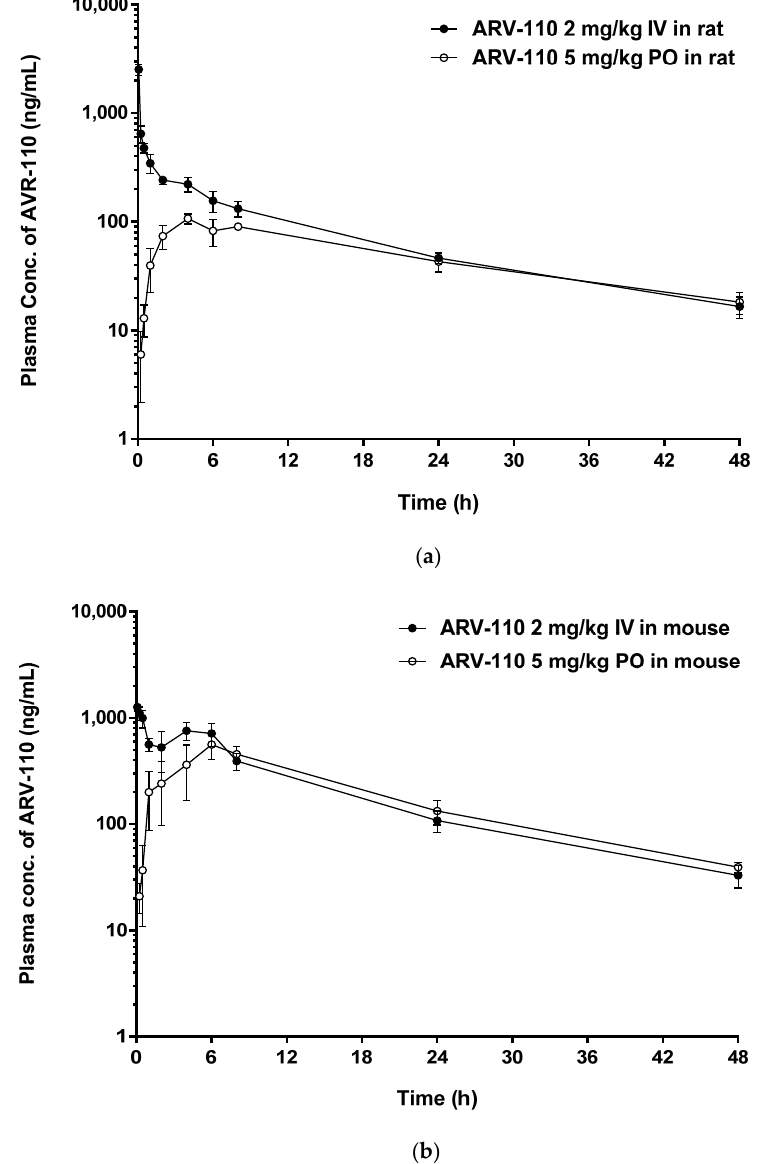
Figure 5. Plasma concentration–time curves after IV administration at 2 mg/kg ( ● ) and PO administration at 5 mg/kg ( ○ ) to rats ( a ); and mice ( b ). Data are presented as mean ± SD ( n = 4). Table 4. Pharmacokinetic parameters of ARV-110 after IV and PO administration to rats and mice ( n = 4).